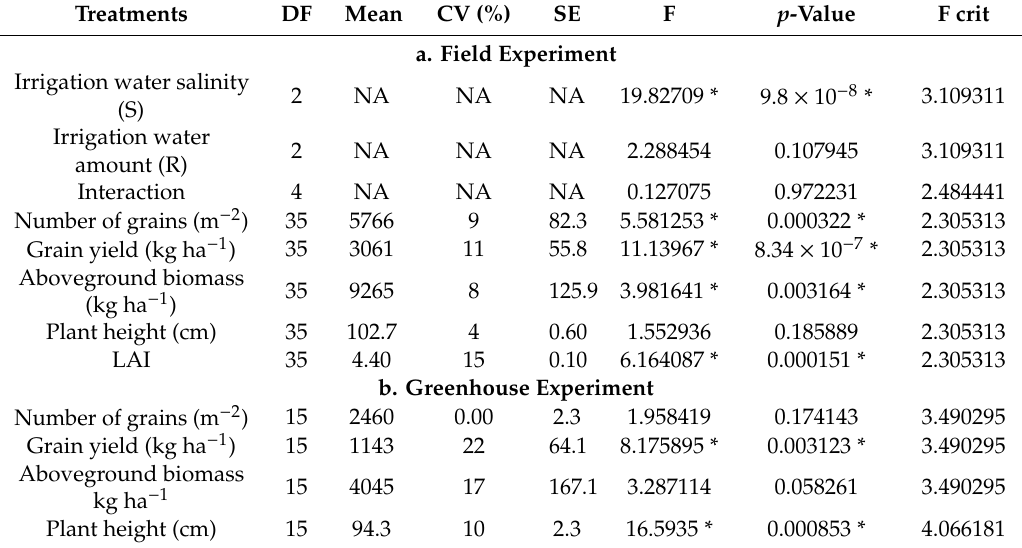
Table 5. ANOVA statistical analysis for the field ( a ) and for the greenhouse ( b ) experiments. Results marked with star symbol * are significant ( p < 0.05). DF: Degree of Freedom, CV: Coe ffi cient of